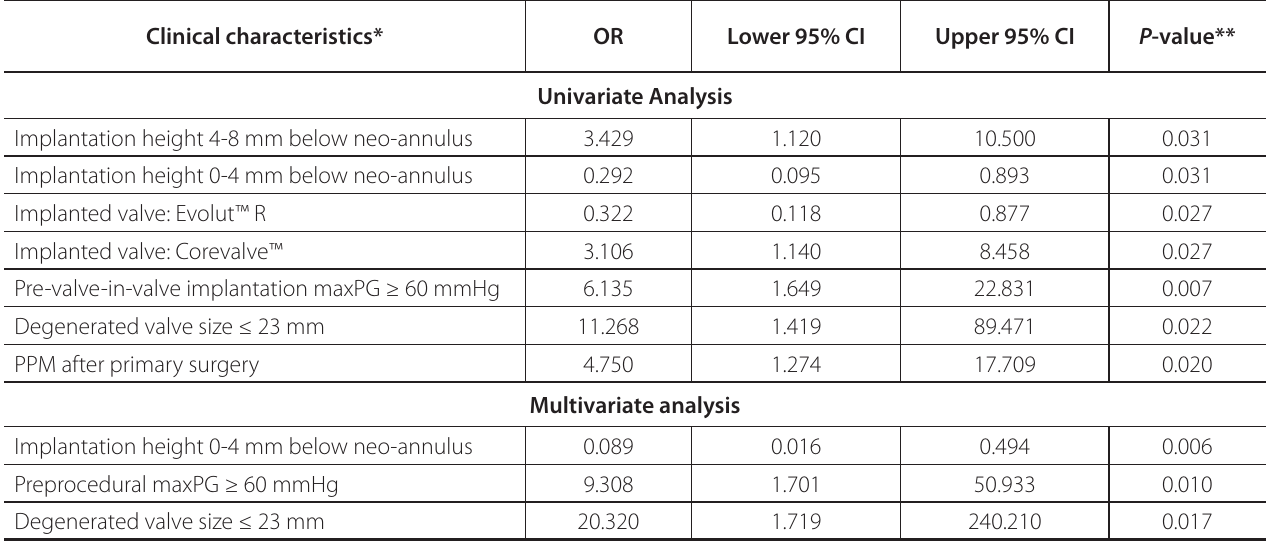
Table 3 . Univariate and multivariate analyses of risk factor for high residual gradient following self-expandable TAVI-ViV. Clinical